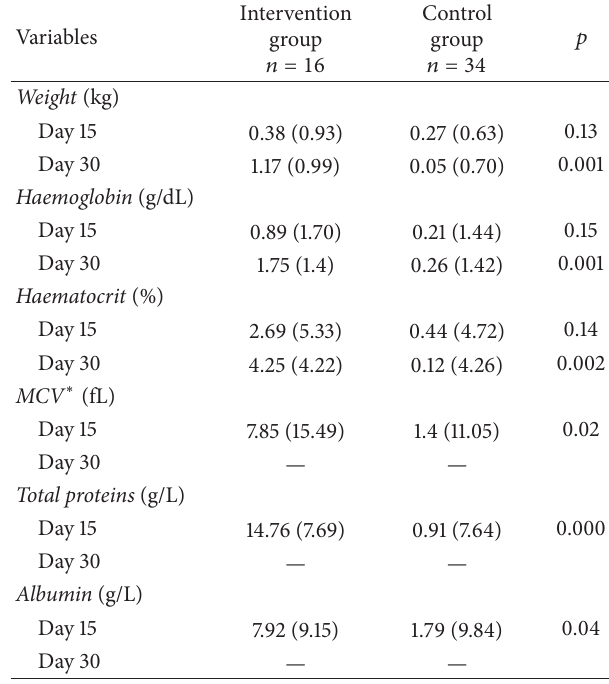
∗ MCV: mean corpuscular